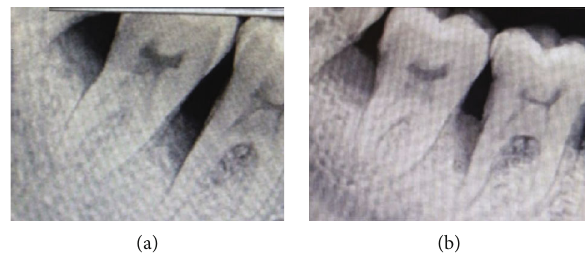
Figure 1: Radiographic image: (a) preoperative and (b) postoperative.